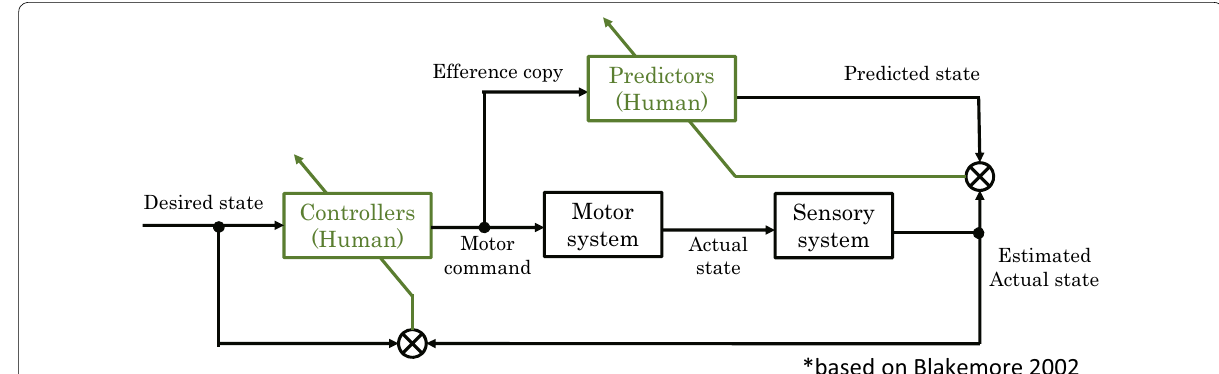
Fig. 1 Information flow for human motor control [20]. Body representation update is the update of controllers and predictors of this feed forward control